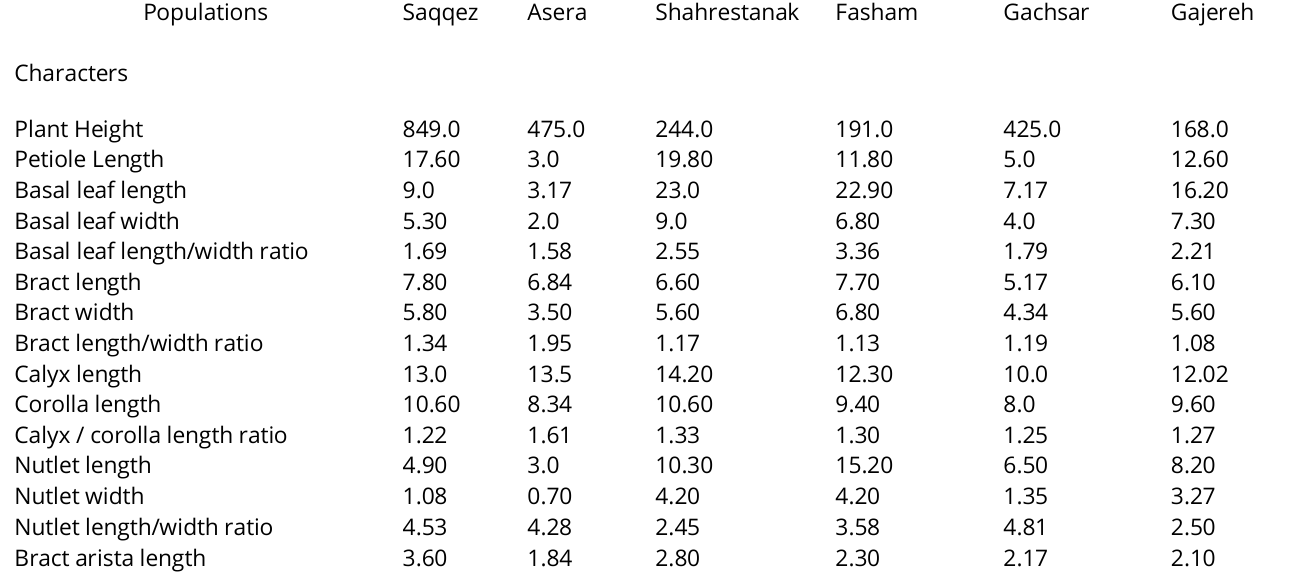
Table2. Details of morphological characters in L. peltata populations studied (all values are in